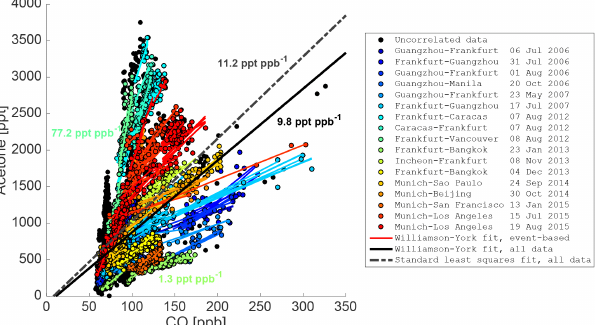
Figure 3. Scatter plot of tropospheric acetone and CO data of 17 se- lected CARIBIC flights. Detected correlations are shown as regres- sion lines plotted in the range of the underlying data. Colour coding denotes to which flight data and correlations belong to. Data, which did not fall into our event-based correlation criteria, are shown as filled black circles regardless of their flight affiliation. The solid black and the grey dashed line represent the results of a Williamson– York fit (EnR: 9.8pptppb − 1 ) and of a standard least-squares fit (EnR: 11.2pptppb − 1 ), respectively, applied to all data of the 17 flights. The minimum, mean and maximum value of the event-based EnRs are 1.3, 18.6 and 77.2, respectively (all values in pptppb − 1